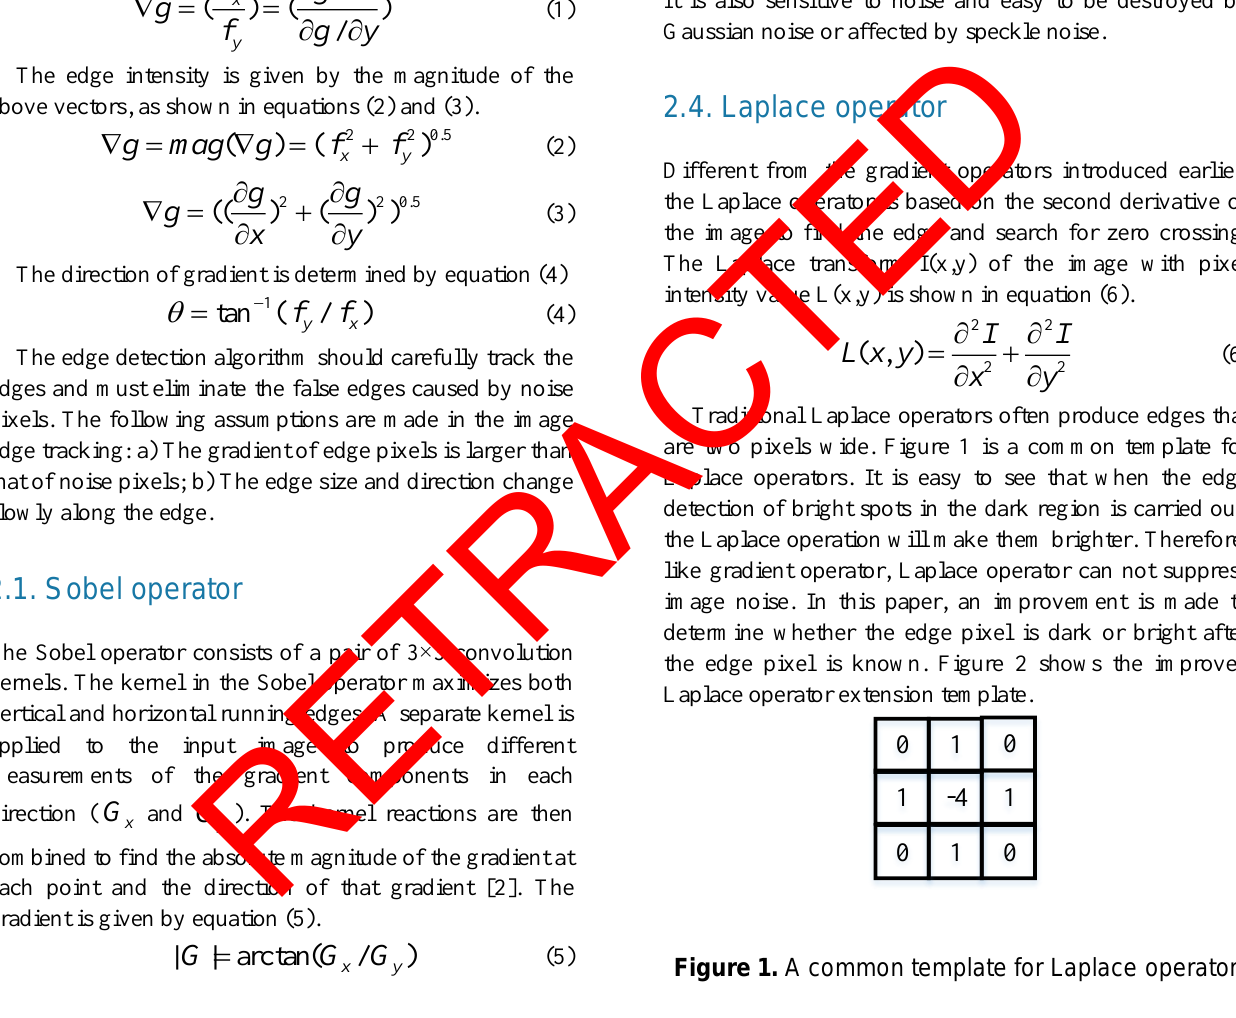
Figure 1. A common template for Laplace operator